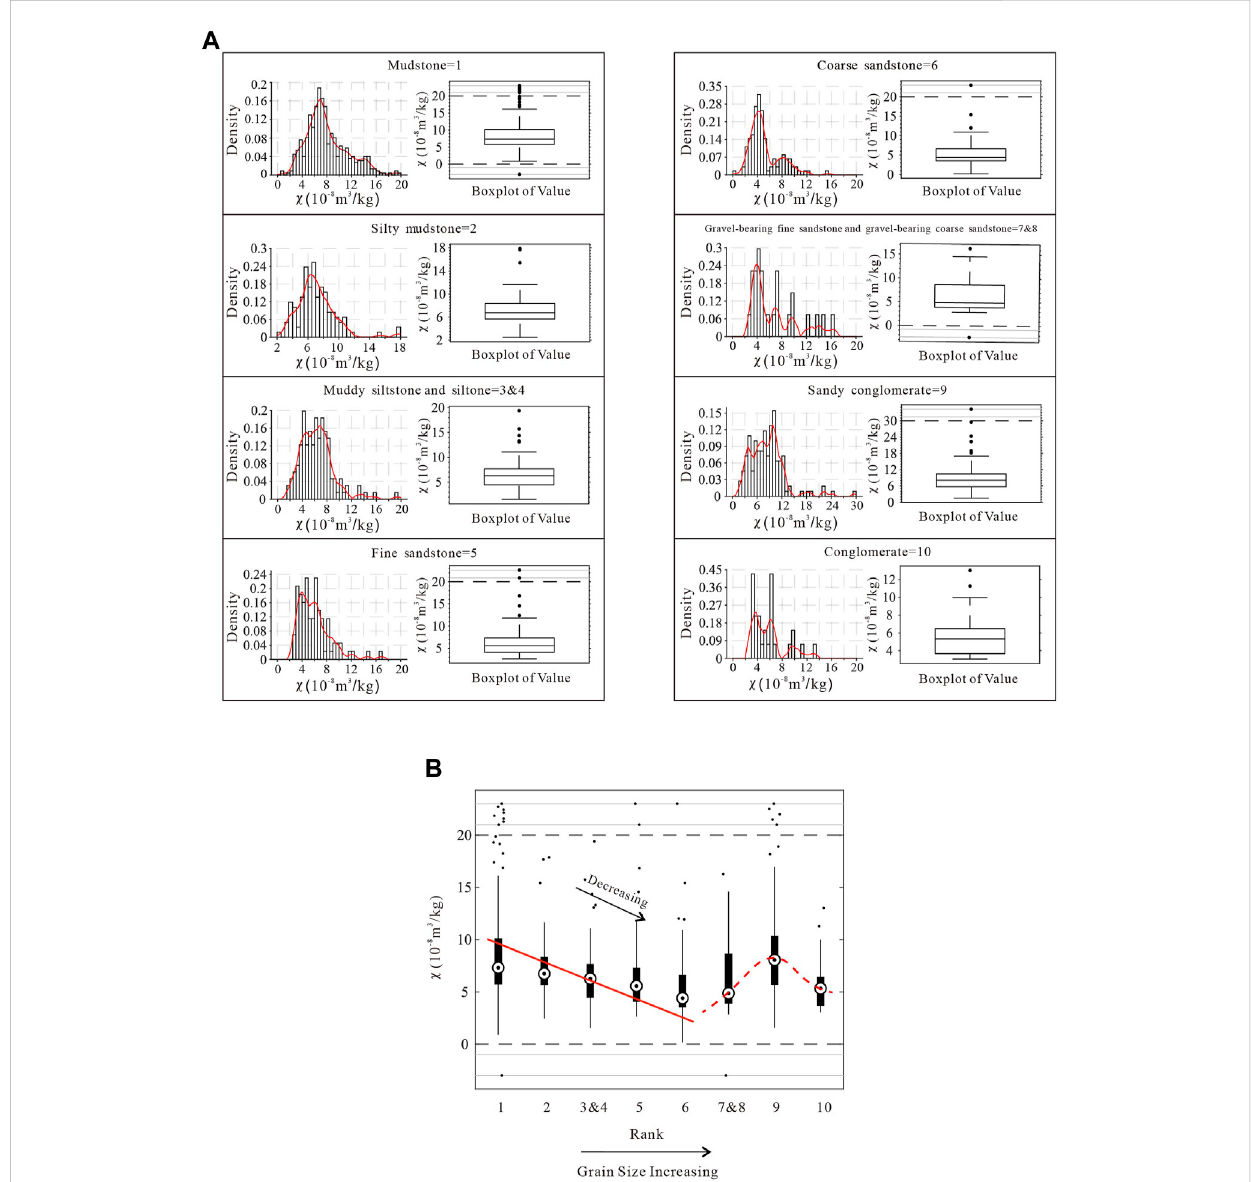
FIGURE 2 (A) Probability density distribution of mass-speci fi c magnetic susceptibility ( χ ) values (left) and boxplot (right) from the SK-2 Well for the ten lithological ranks. Mudstone (Rank = 1), silty mudstone (Rank = 2), muddy siltstone (Rank = 3) and siltstone (Rank = 4), fi ne sandstone (Rank = 5), coarse sandstone (Rank = 6), gravel-bearing fi ne sandstone (Rank = 7) and gravel-bearing coarse sandstone (Rank = 8), sandy conglomerate (Rank = 9), and conglomerate (Rank = 10) (B) Relationship between χ values and lithological ranks of the lower K 1 sh Formation in the SK-2 Well. Rank values are the same as (A)